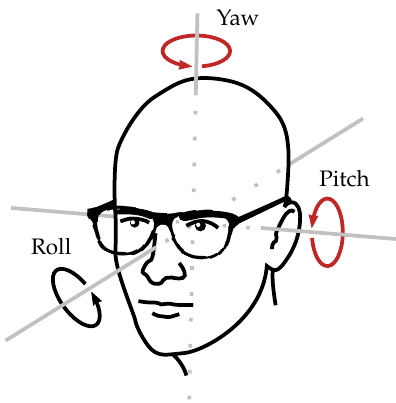
Figure 3. The roll, pitch and yaw angle in human head movement. For two-dimensional movement of the mouse pointer, only pitch and yaw angles are used. The angles are converted into a cursor position considering the screen resolution.